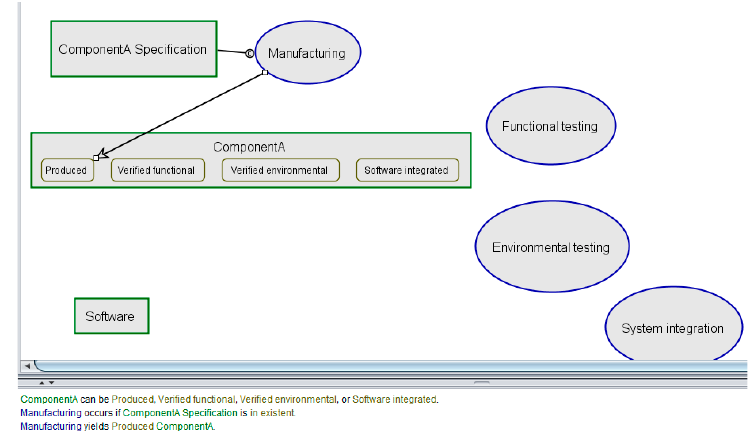
Figure 5. Linking objects and process, option #4.